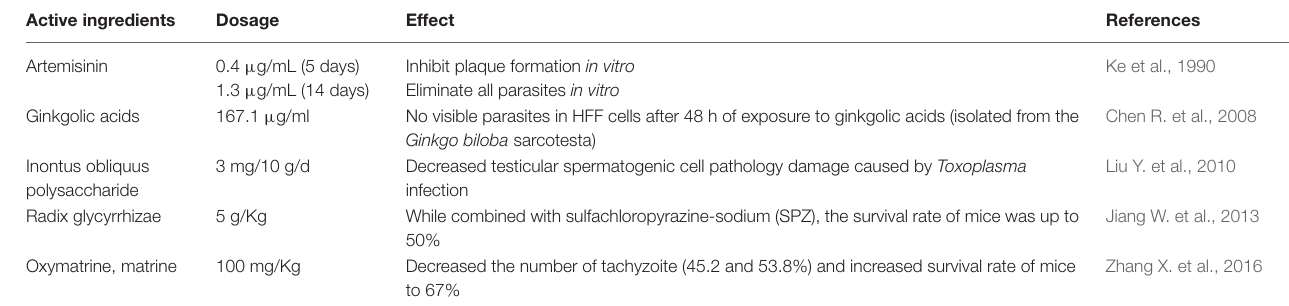
TABLE 4 | Effects of herbal medicines or their active components on Toxoplasma gondii . Active